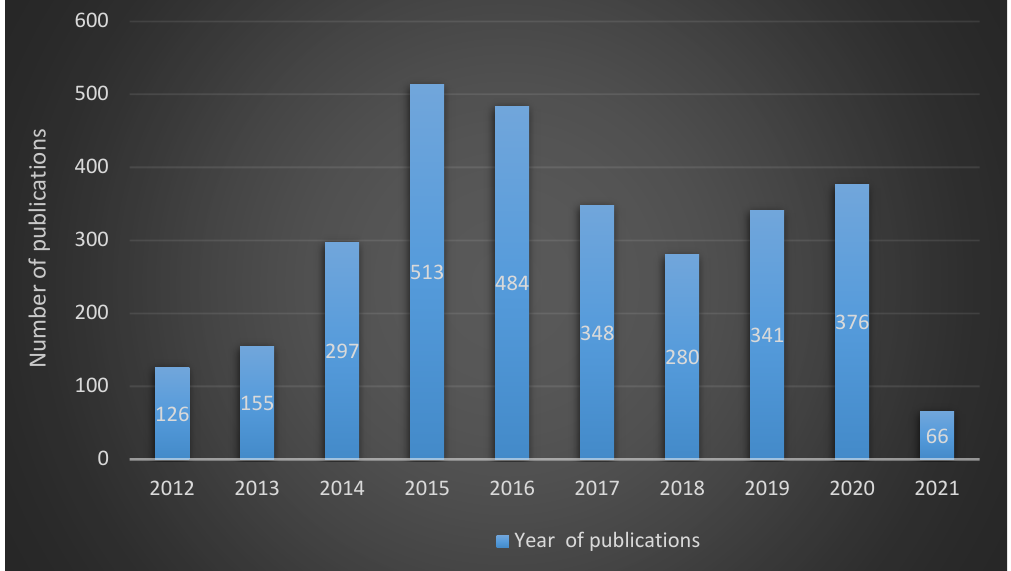
Figure 4. Years, with their number of publications.